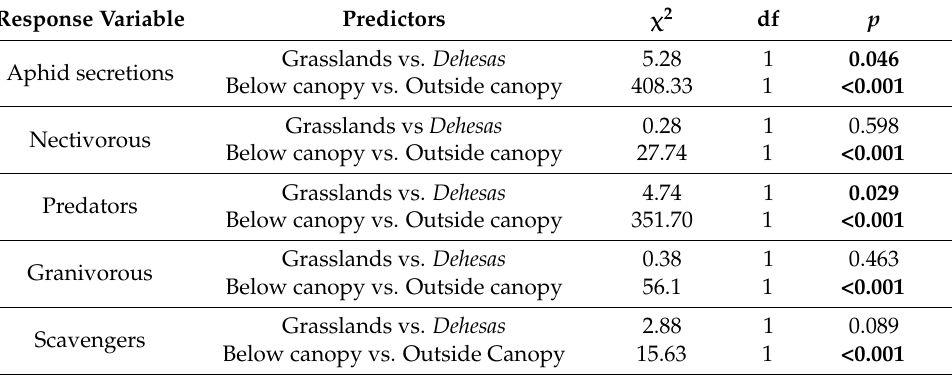
Figure 3. Graph depicting the number of species of soil nesting ants collected per pitfall trap ( mean ± SE ) in: ( a ) grasslands and dehesas and ( b ) below and outside tree canopies within dehesas . Different colors represent the different trophic groups (ants feeding on aphid secretions, nectivorous, predators, granivorous, and scavengers). Table 3. Differences between habitats (grasslands vs. dehesas ) and between microhabitats (below and outside oak canopies within dehesas ) in the number of species of the different trophic groups (ants feeding on aphid secretions, nectivorous, predators, granivorous and scavengers). Significant p -values are shown in bold.